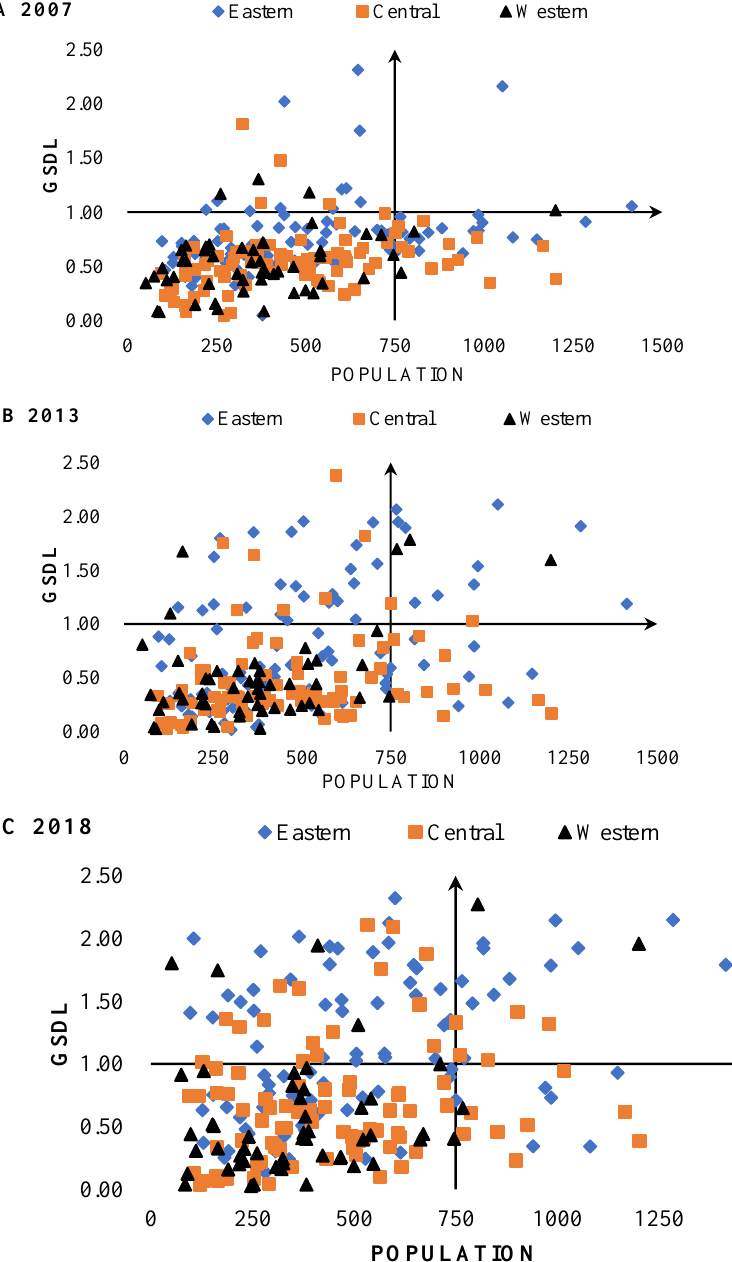
Figure 4. The spatial trend of the urban GSDL (Green and Smart Development Level) in China in the year of 2007 ( A ), 2013 ( B ), and 2018 ( C ) respectively.